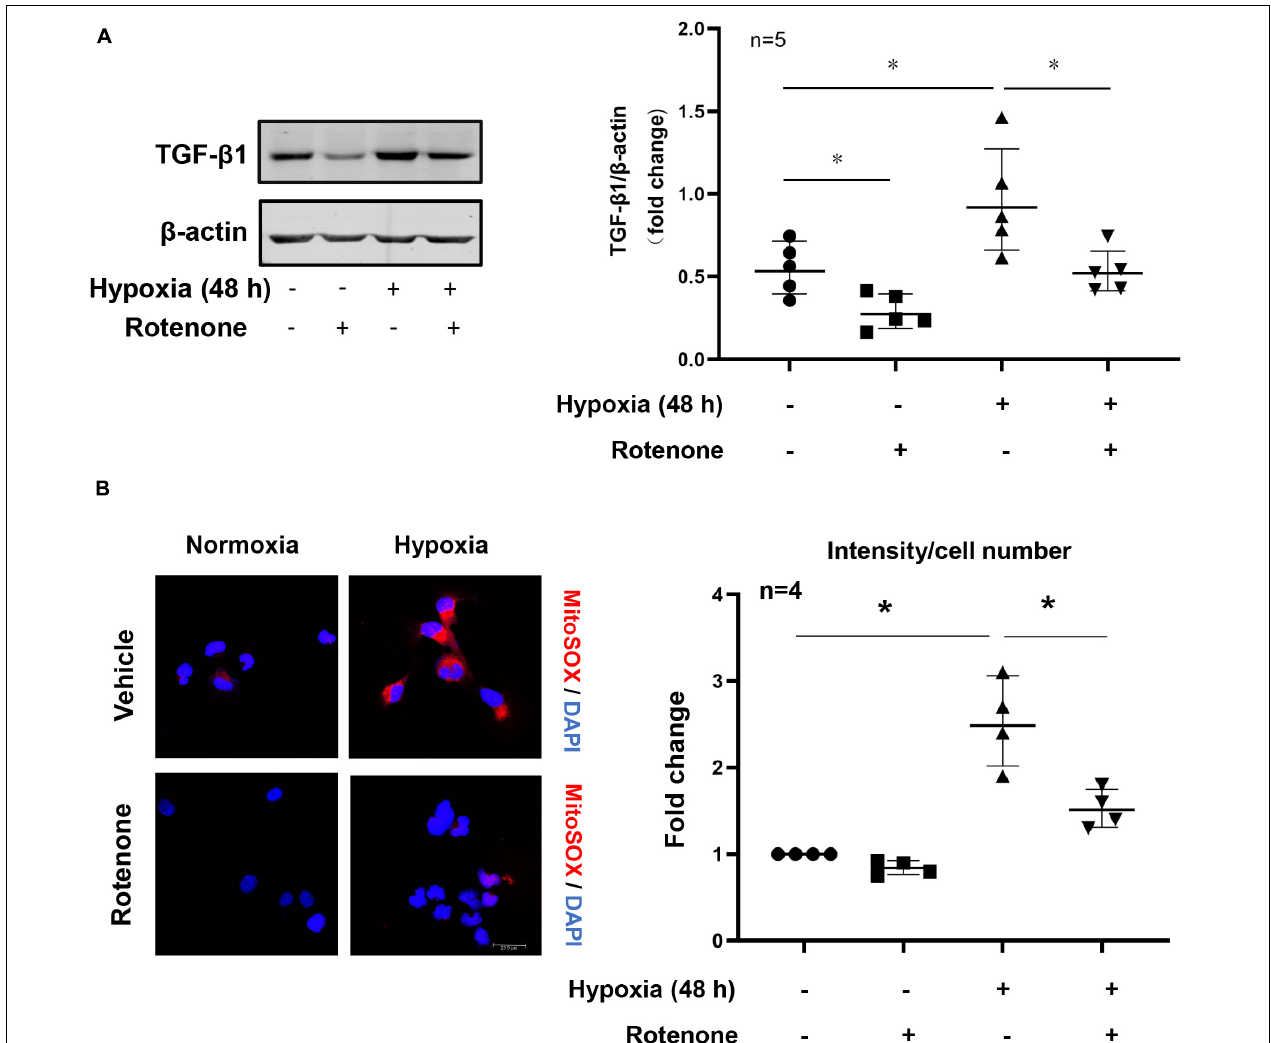
FIGURE 6 | Effects of mitochondrial stress on hypoxia-induced TGF β 1 expression in HK2 cells. (A) Immunoblotting analysis of TGF β 1 expression in HK2 cells which were pretreated with rotenone (2 µ mol/L for 1 h) and then exposed to hypoxia conditions for 48 h; the graph of right shows quantification of the signals on immunoblots; (B) cellular mitochondrial ROS generation as detected by MitoSox staining (red) followed by nuclei staining with DAPI under confocal microscope. The plot graph shows quantification of the signals. Scale bar = 29.9 µ m. * p < 0.05 between the indicated groups. Student’s t -test was performed between the indicated two